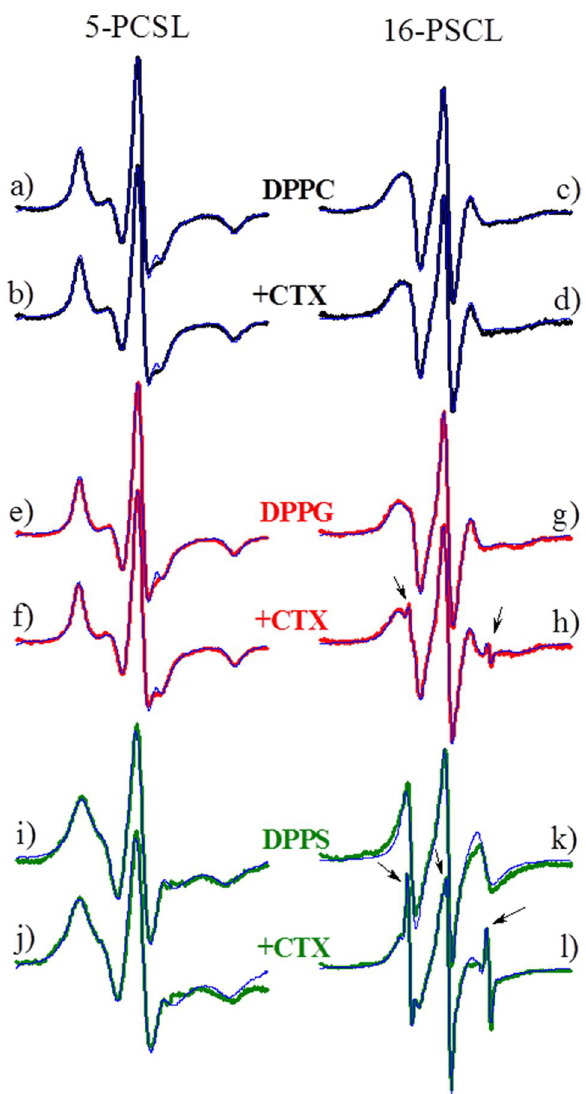
Figure 5. Typical ESR spectra of 5-PCSL and 16-PCSL spin labels incorporated into the gel phase of pure lipid bilayers of DPPC ( a , c , black lines), DPPG ( e , g , red lines) and DPPS ( i , k , olive lines), and the mixtures of 0.1 mol% CTX relative to the lipid concentration of DPPC ( b , d , black lines), DPPG ( f , h , red lines) and DPPS ( j , l , olive lines). The spectra were acquired at 20 °C, and its total width is 100 G. Blue lines correspond to the best fittings of the experimental spectra by the theoretical simulations (see